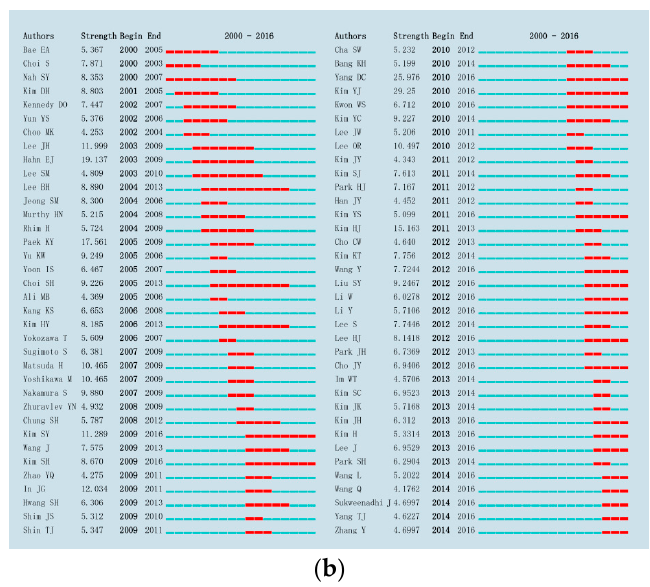
Figure 4. Authors with highest publication numbers and burst detection result. ( a ) Top 10 highest publishing authors and total local citation score; ( b ) Authors with strongest burst since 2000.